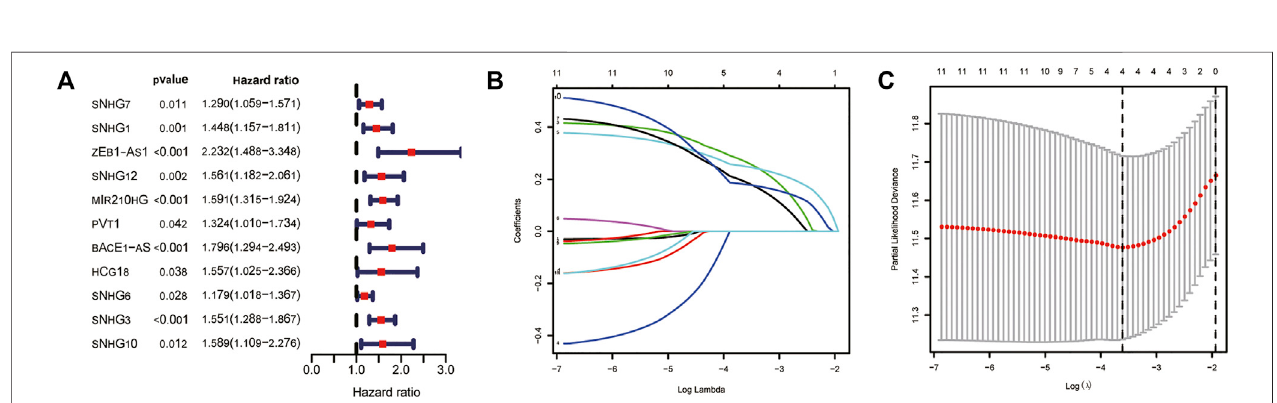
FIGURE 2 | Construction of m6A-related lncRNA signature using the TCGA dataset. (A) The univariate Cox regression model identi fi es lncRNAs that affect overall survival; (B,C) Lasso Cox regression model to identify the best penalty parameter. TCGA, The Cancer Genome Atlas; Lasso, Least absolute shrinkage and selection